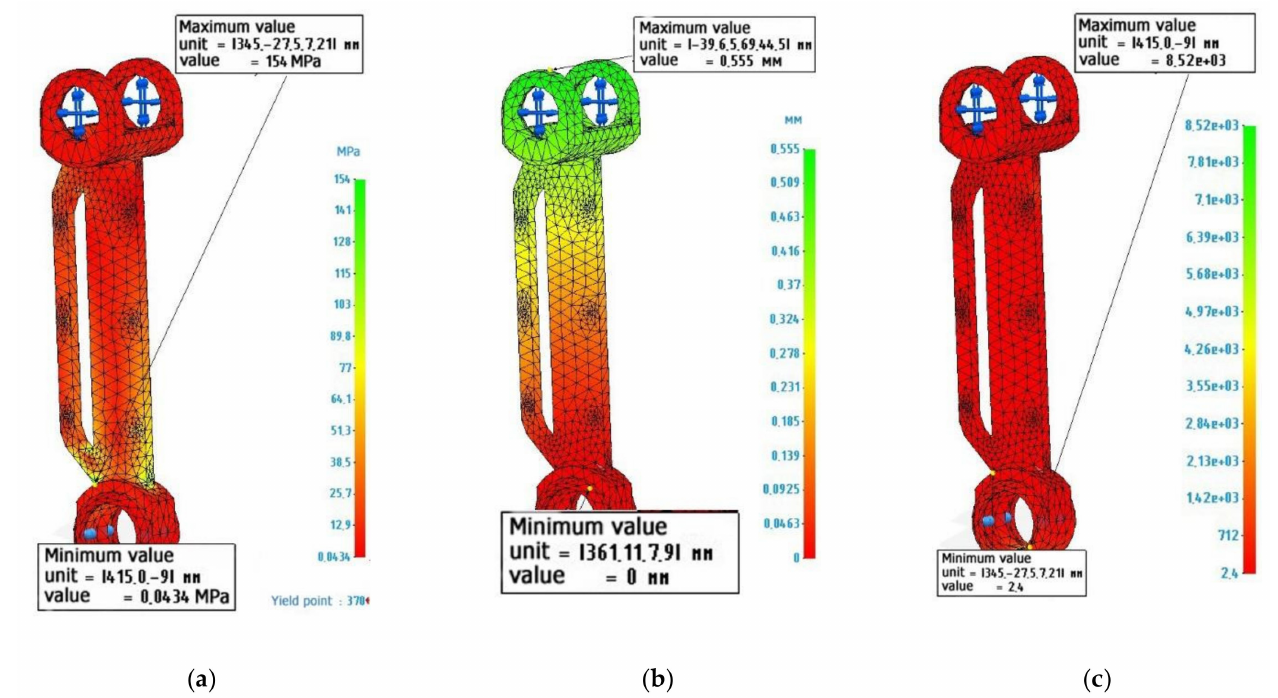
Figure 3. Finite element design of an exoskeleton lever made of stainless steel: ( a ) Von Mises stress diagram, maximum value 154 MPa; ( b ) Strain diagram, maximum value 0.555 mm: ( c ) Safety factor diagram, minimum value